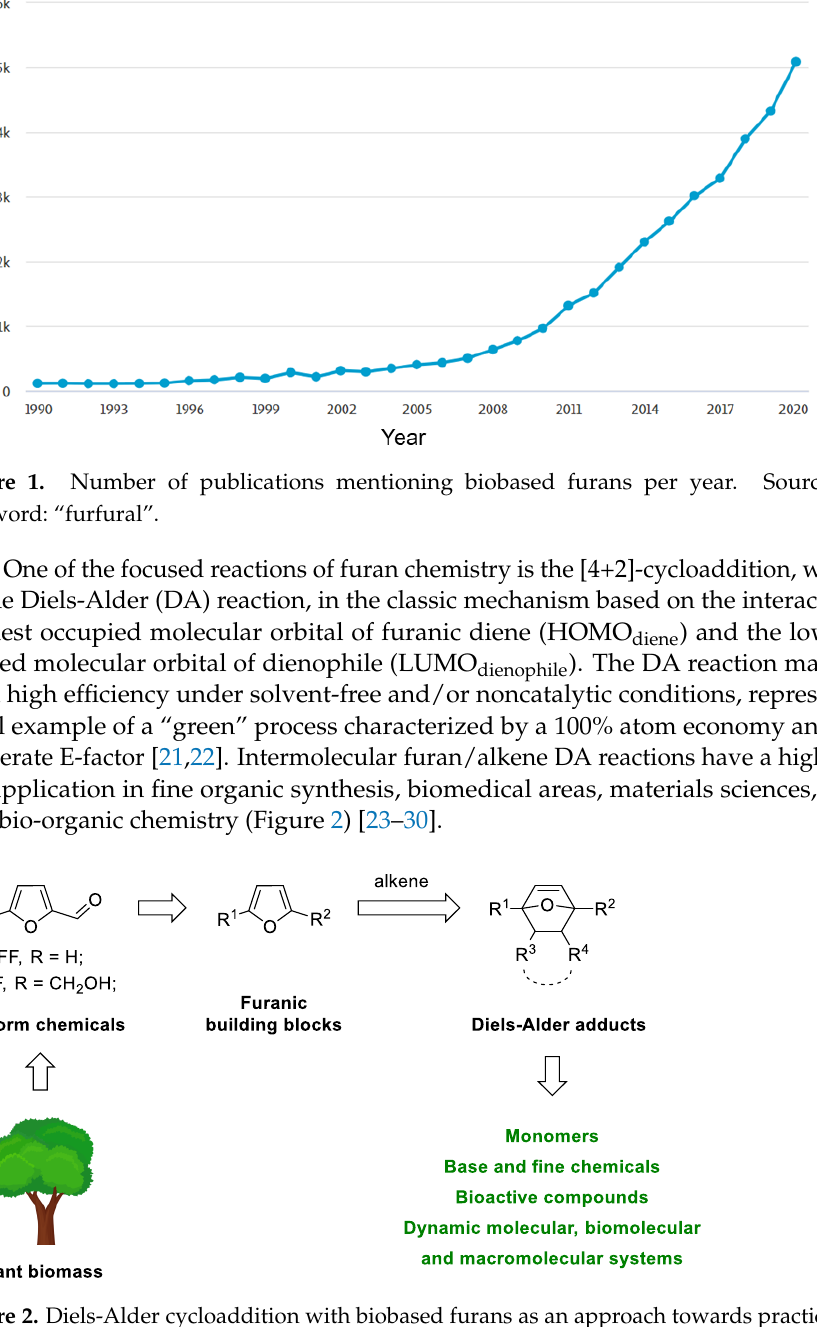
Figure 2. Diels-Alder cycloaddition with biobased furans as an approach towards practically impor- tant products. Summarizing and analyzing scientific data about the regio- and diastereoselectivity of intermolecular Diels-Alder cycloadditions between furfural derivatives and alkenes was a general aim of this review.